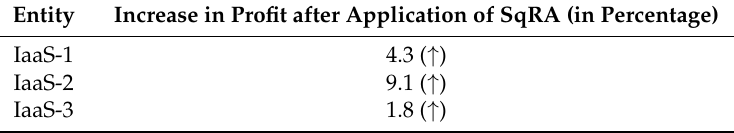
Table 3. Increase in profit earned by the Infrastructure-as-a-Service (IaaS) providers after implementing Square Root Algorithm (SqRA).